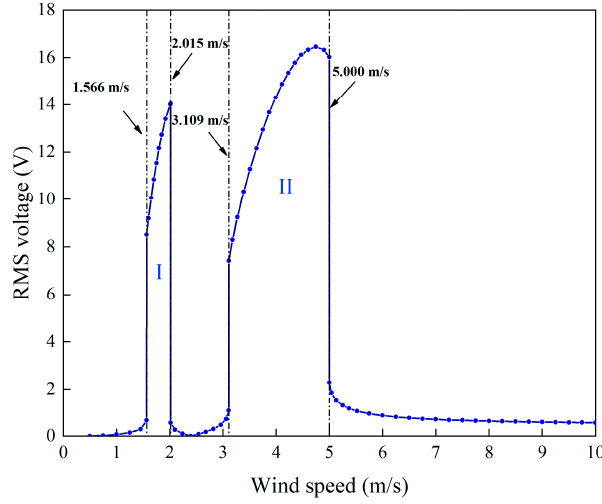
Figure 7. Enlarged view of the time history voltage response over two cycles.